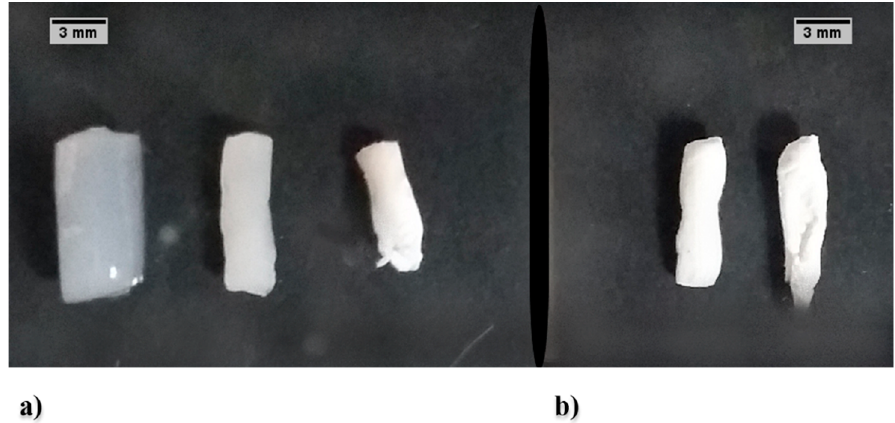
Figure 2. Acemannan gels. ( a ) AC hydrogel (left), acetogel (center) and aerogel (right) obtained by M1 process. ( b ) AC acetogel (left) and aerogel (right) obtained by M2 process.